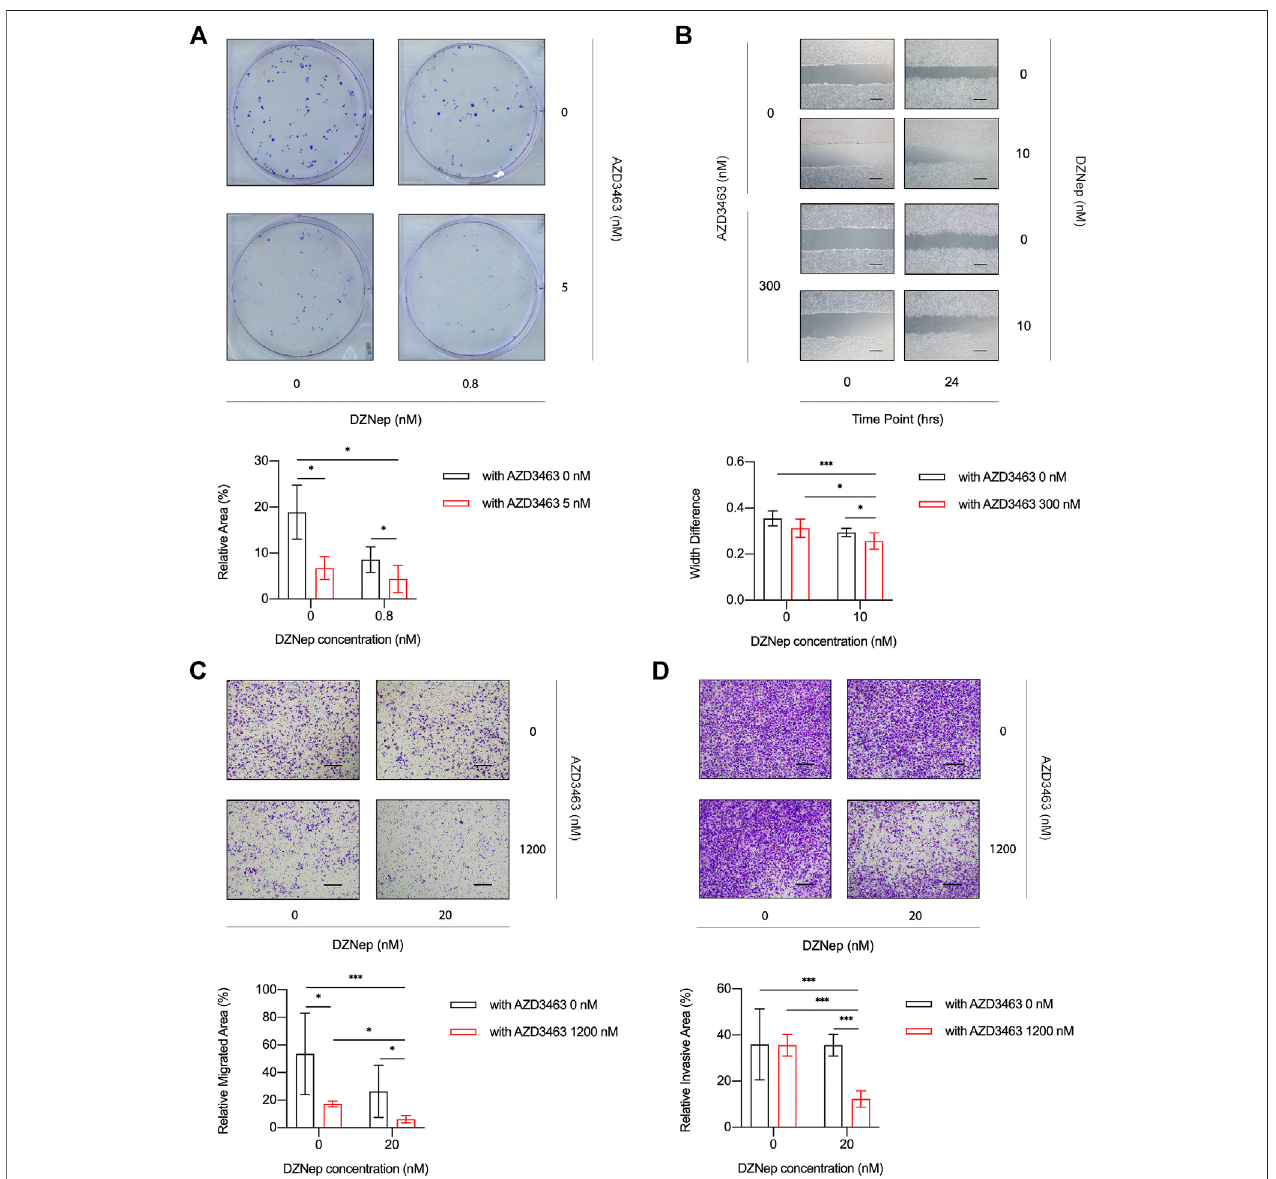
FIGURE4| DZNepandAZD3463inhibitedbreastcancercellproliferation,migration,andinvasion invitro . (A) MDA-MB-231cellsformedfewercoloniesatday5in the presence of AZD3463 (5 nM) or DZNep (0.8 nM), and the effect of DZNep was enhanced by AZD3463. (B) Wound healing assays showing that AZD3463 (300 nM) and DZNep (10 nM) inhibited scratch wound healingcompared tothecontrolgroupat 24 h, and the combination group had the largest gap at 24 h. Scale bar (cid:2) 10 μ m. (C) Transwell assays showing that the relative area of migrated (C)cells was decreased by AZD3463 (1,200 nM) and DZNep (20 nM), and the combination (20 nM DZNepand1,200 nMAZD3463)grouphadthelargestdecrease.Scalebar (cid:2) 10 μ m. (D) Transwellassaysshowingthattherelativeareaofinvasive(D)cellsdecreasedin the combination (20 nM DZNep and 1,200 nM AZD3463) group, while other groups were similar to the control group. Scale bar (cid:2) 10 μ m.